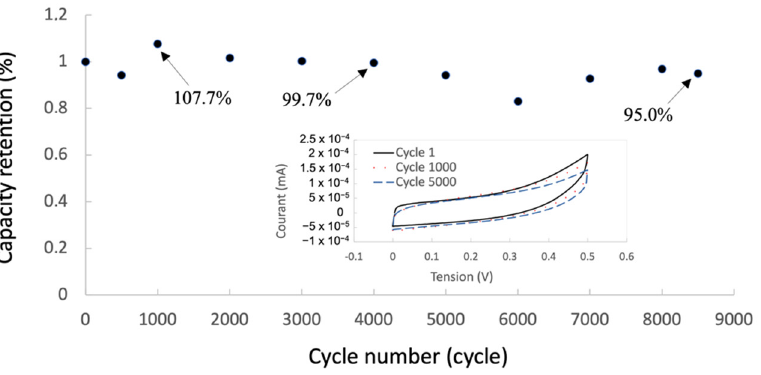
Figure 7. Evolution of the specific capacitance as a function of cycles at 20 mV · s − 1 . The inset shows voltammograms for the initial, 1000th and 5000th cycles.